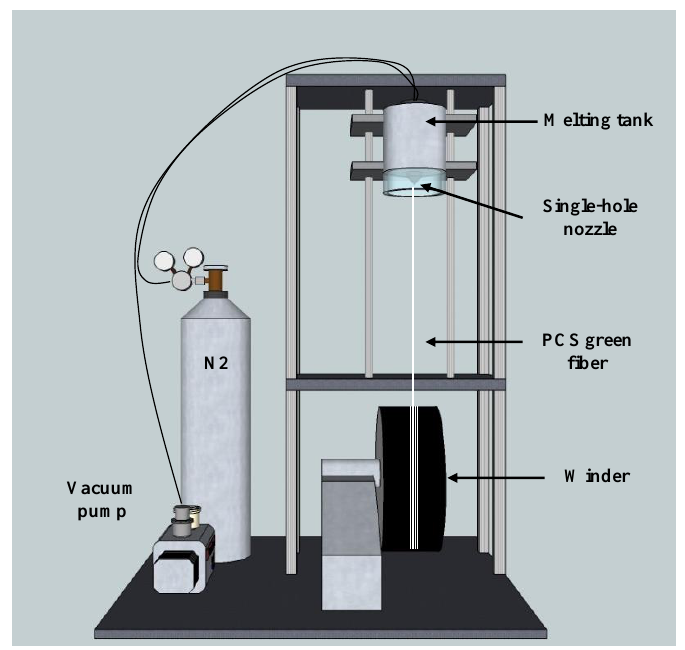
Figure 1. The schematic drawing of melt-spinning machine equipped with a single-hole nozzle.